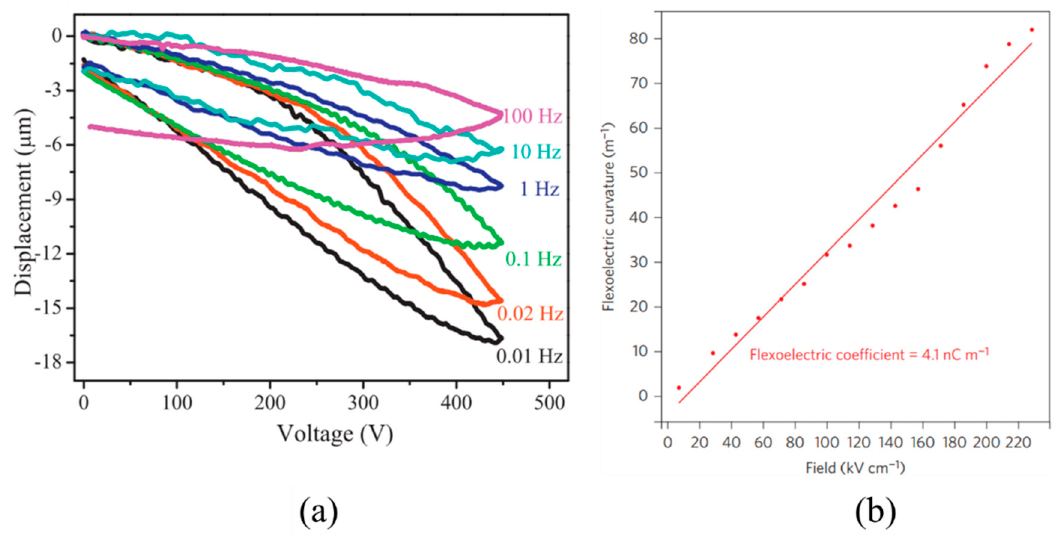
Figure 18. ( a ) Unipolar displacement of reduced NBBT8 ceramics under different voltages at different frequencies. Reprinted with permission from [117]. Copyright 2017 Elsevier. ( b ) The linear variance of the first-harmonic flexoelectric curvature with the applied ac field at a frequency of 100 kHz of MEMS actuators fabricated by SrTiO 3. Reprinted with permission from [19]. Copyright 2015 Springer Nature.